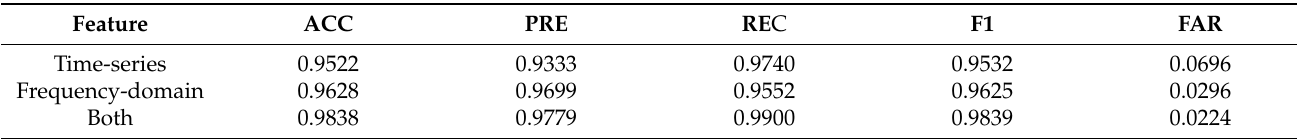
Table 6. Comparisons of different feature selection